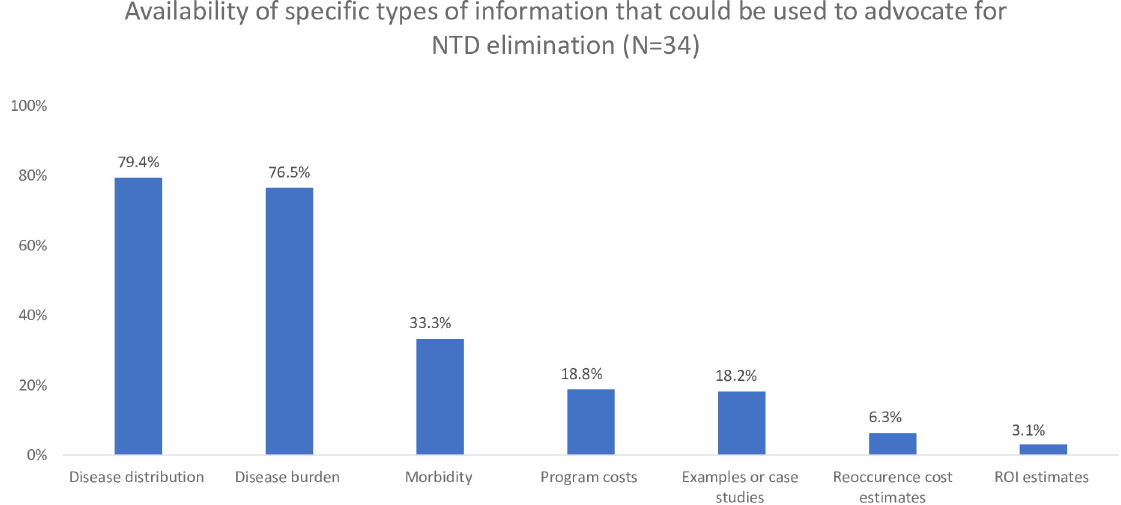
Fig 1. Availability of specific types of information that could be used to advocate for NTD elimination ( n = 34).